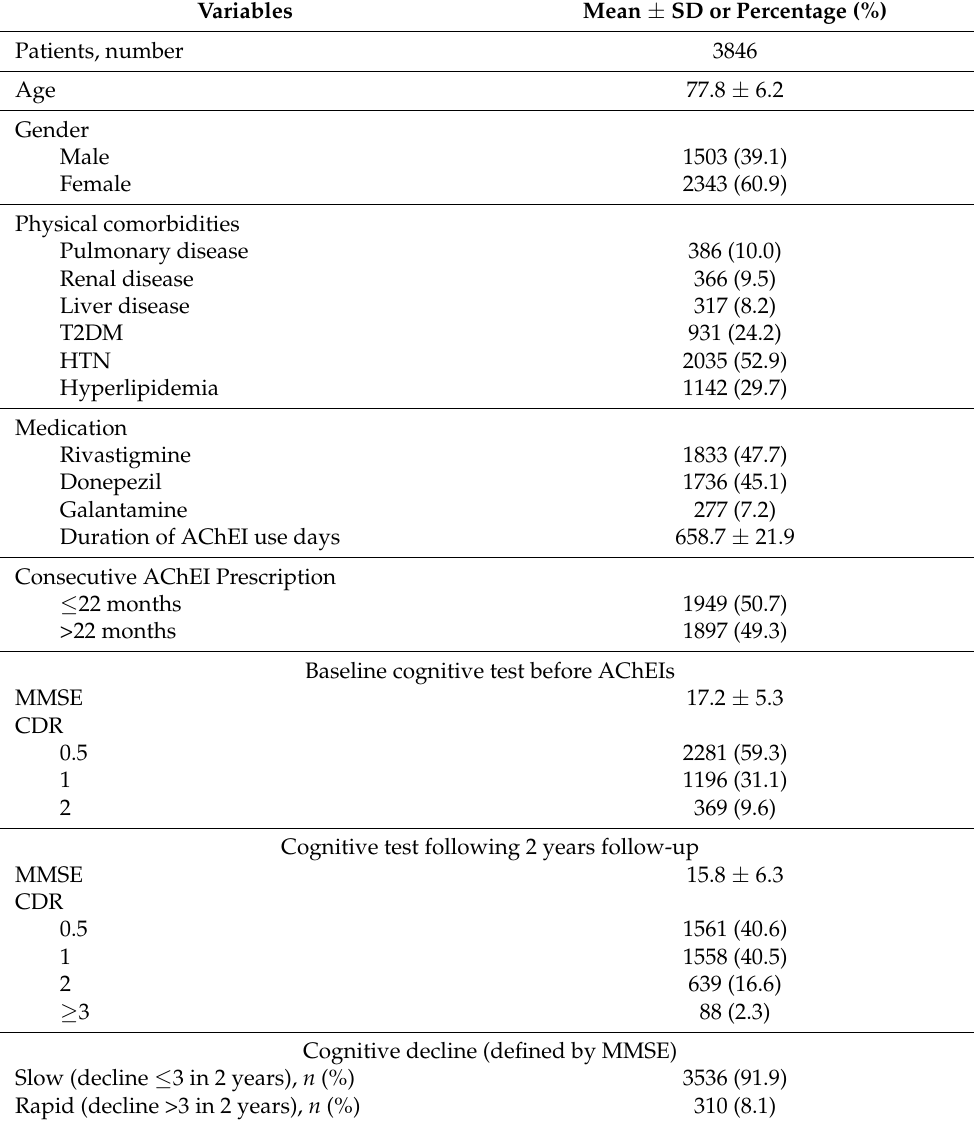
Table 1. Demographic and clinic characteristics of patients with Alzheimer’s